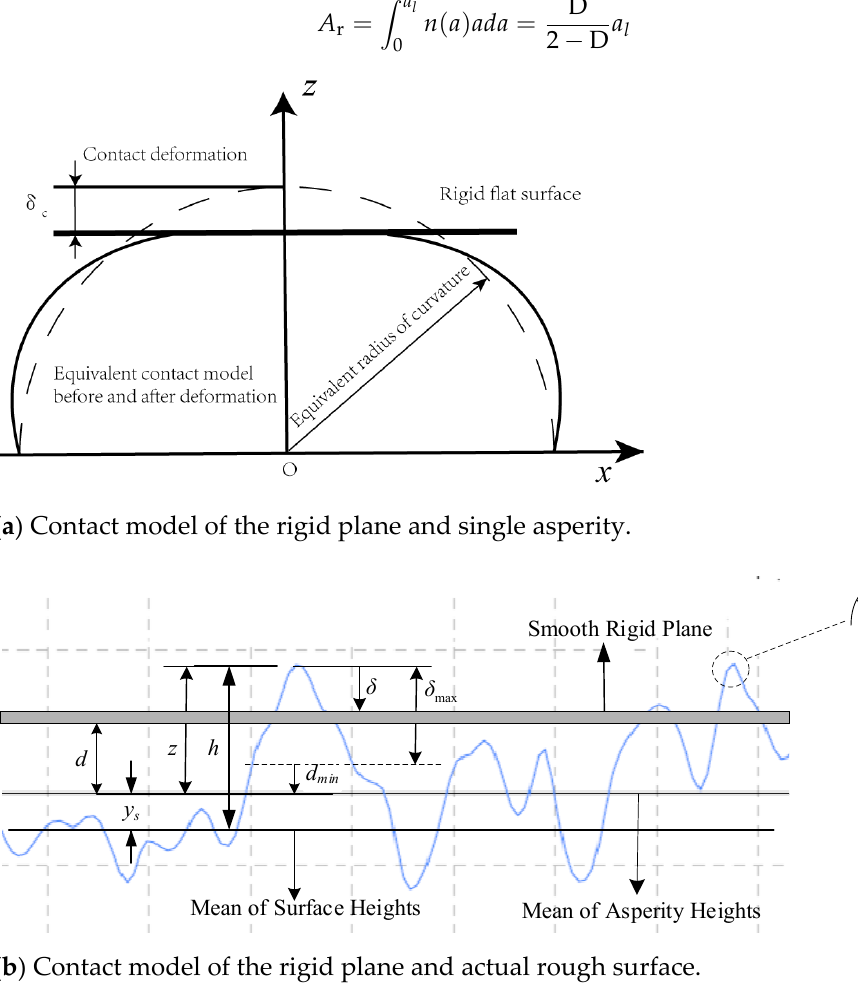
Figure 2. Schematic diagrams of the geometry of contact; ( a ) the rigid plane and single asperity ( b ) the rigid plane and actual rough surface.